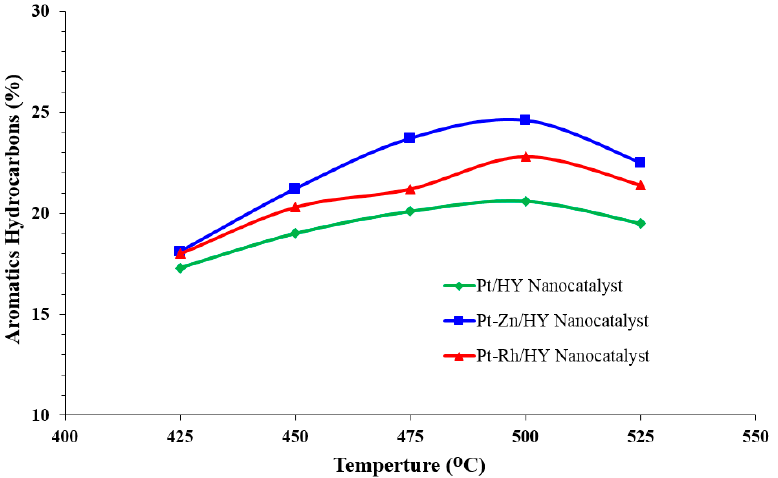
Figure 5. Influence of the catalytic reforming temperature on the aromatic hydrocarbon production rate over the synthesized Pt/HY, Pt-Zn/HY, and Pt-Rh/HY